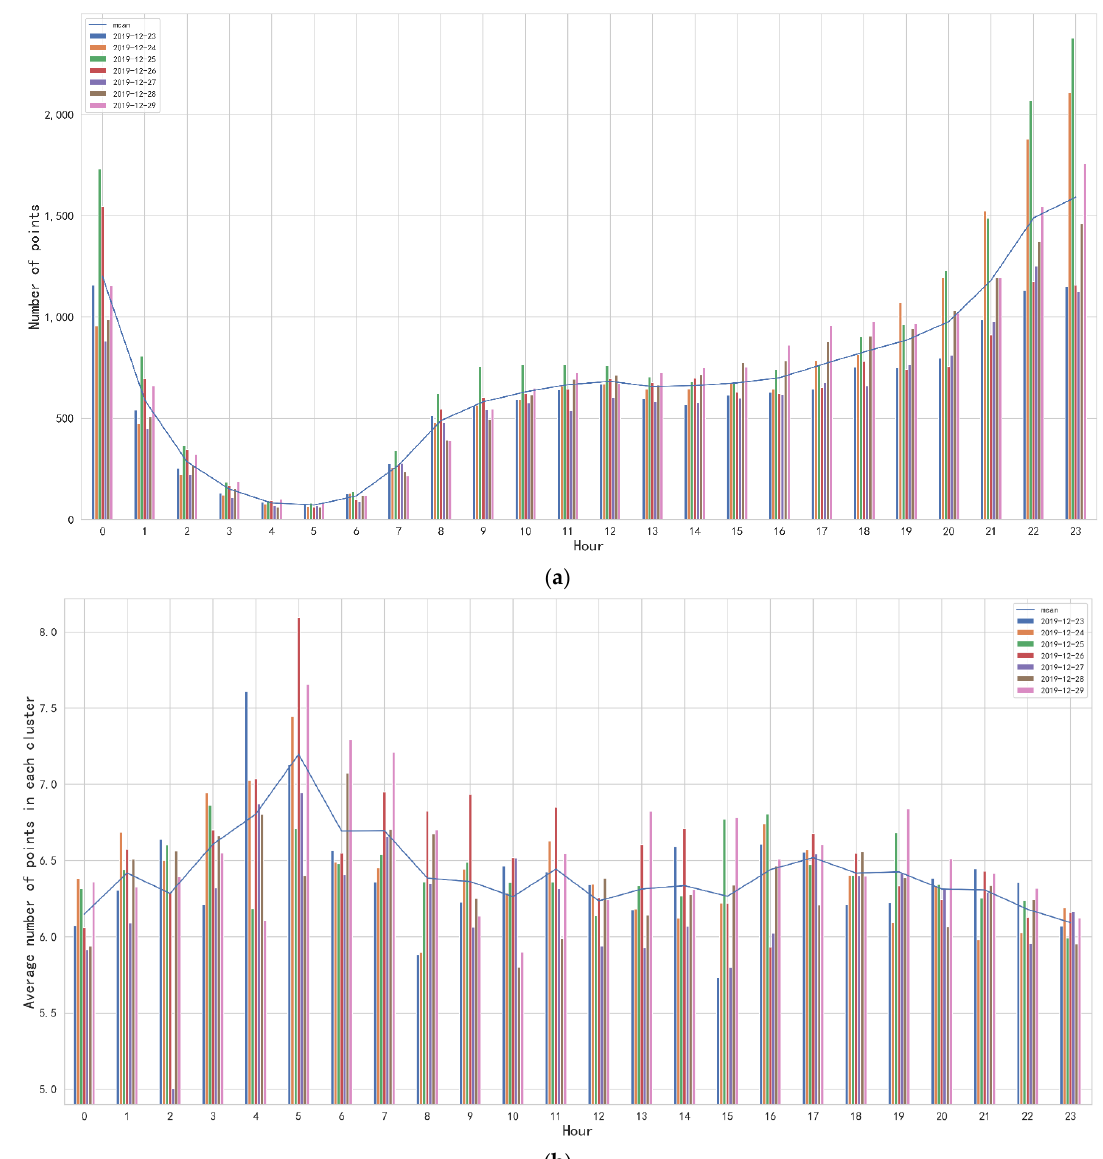
Figure 15. Temporal characteristics of the dataset of a week and the clustering result: ( a ) number of all points and ( b ) average number of points in each cluster.